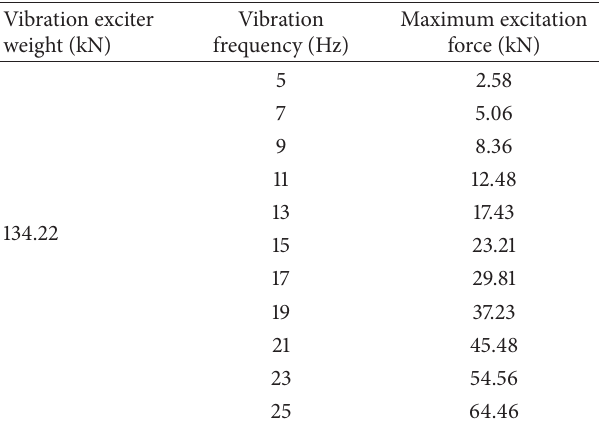
Table 1: Loading indices of frequency sweeping test.